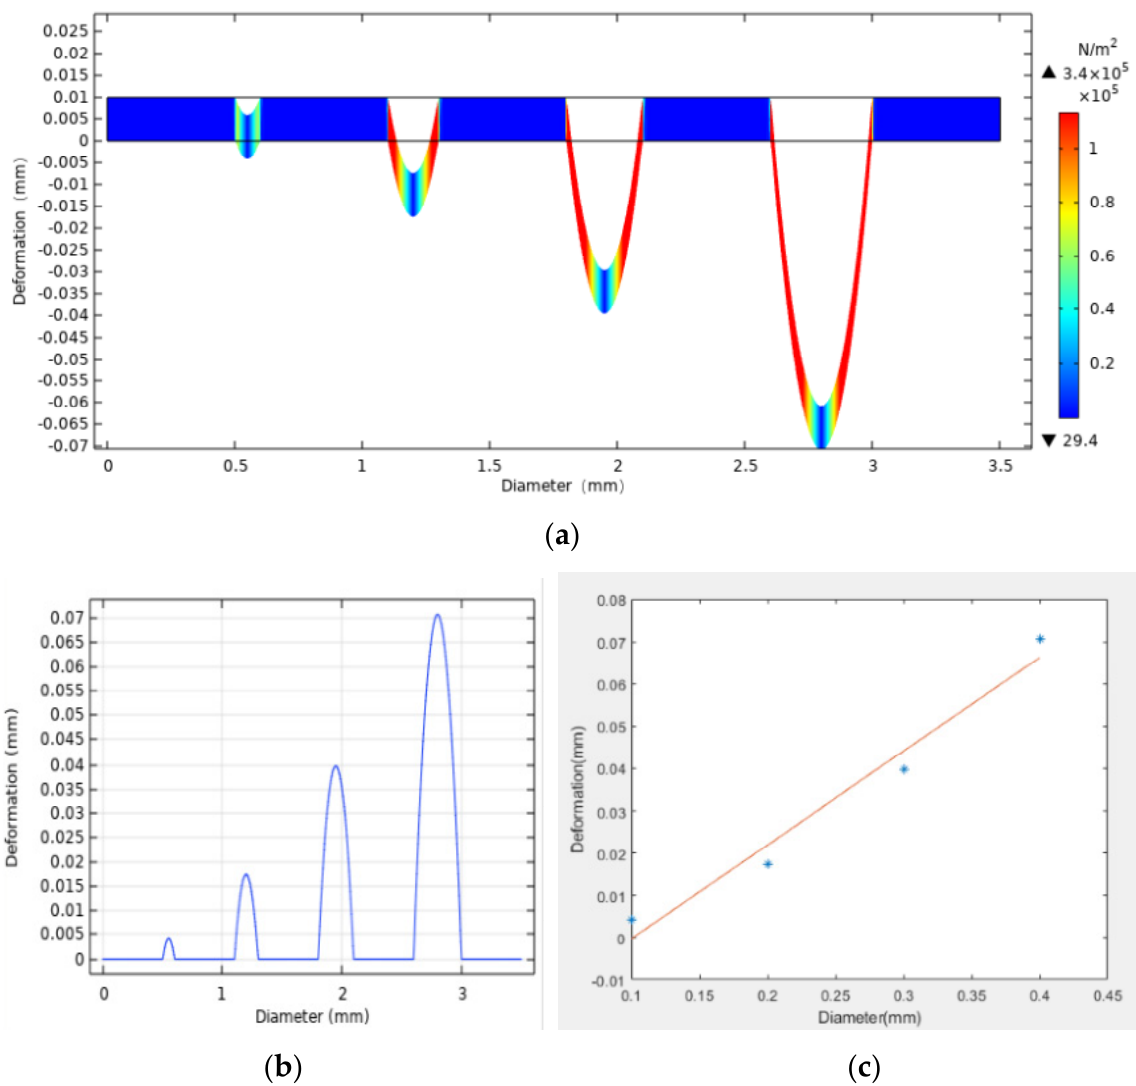
Figure 2. Schematic view of the results of the simulation. The thickness of the film is 10 µ m, the pressure is 8000 Pa, and the diameters of the ommatidia are 0.1, 0.2, 0.3, and 0.4 mm. ( a , b ) The deformation of the ommatidia; ( c ) the linear relationship between the deformation and the diameters.